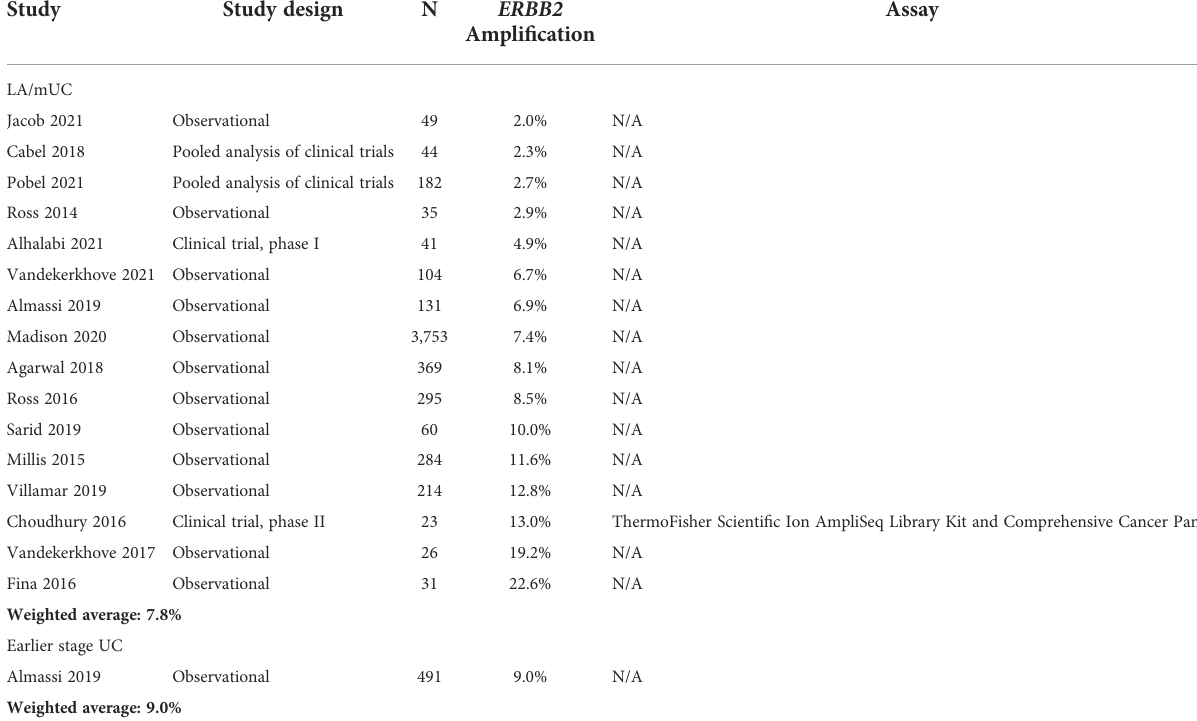
TABLE 5 Overview of ERBB2 ampli fi